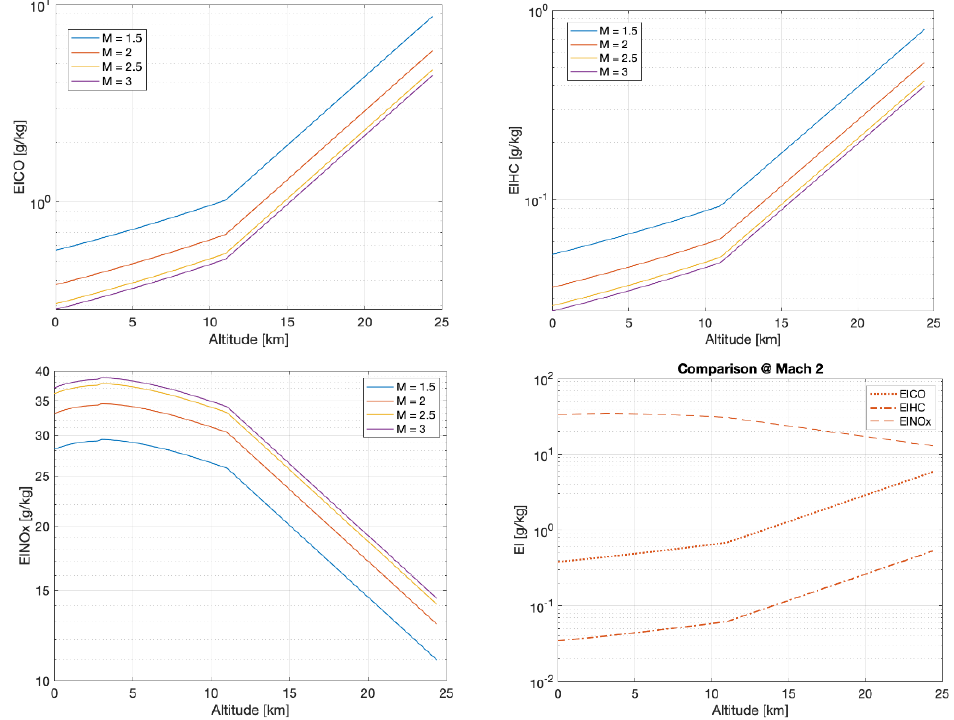
Figure 6. Emission indexes variation as function of altitude at different cruise Mach.